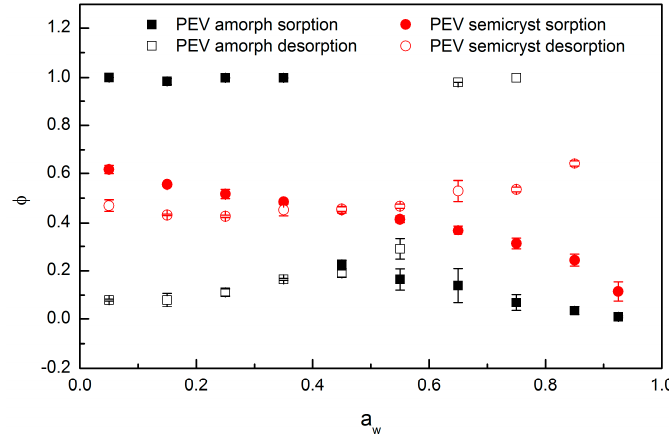
Figure 9. Plot of ϕ from the BH model for water vapor at 20 ◦ C in amorphous and semicrystalline Figure 9. Plot of φ from the BH model for water vapor at 20 °C in amorphous and semicrystalline PEV for sorption and desorption (two replicates for each point). PEV for sorption and desorption (two replicates for each point).